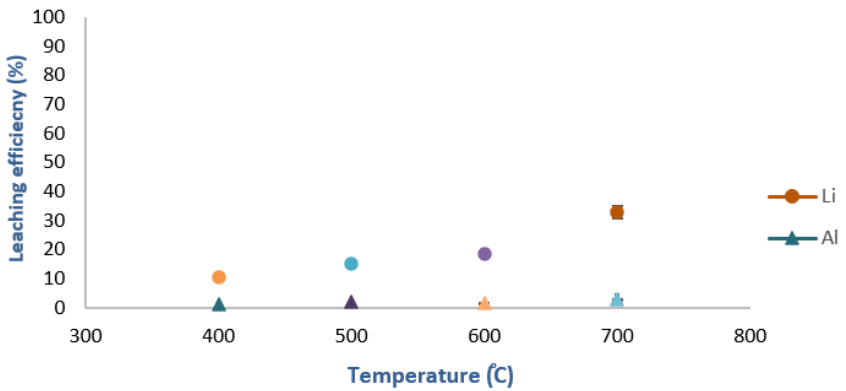
Figure 7. The effect of 10% excess of carbon on leaching of Li and Al from pyrolyzed samples. (Leaching condition: L/S ratio = 20:1 mL g −1 , 80 °C, 300 rpm, and 1 h).